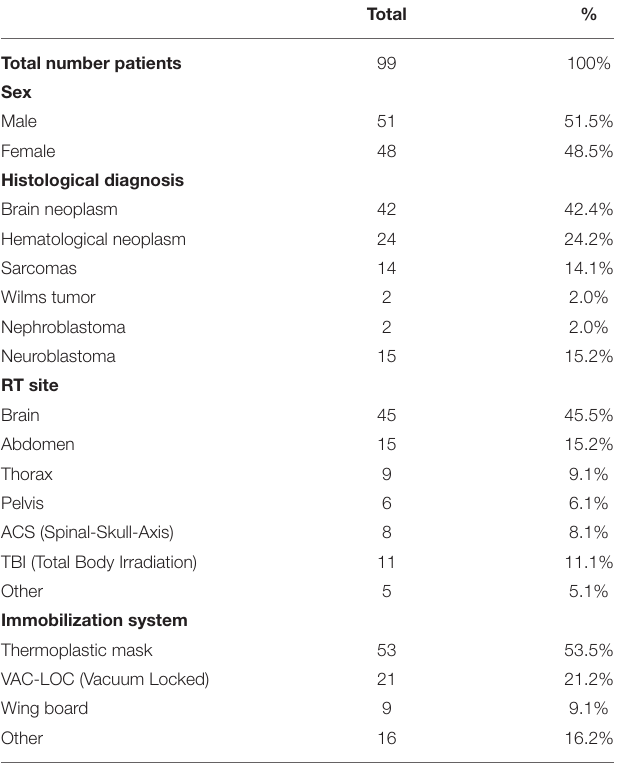
TABLE 2 | Descriptive statistics and epidemiology of patients population.